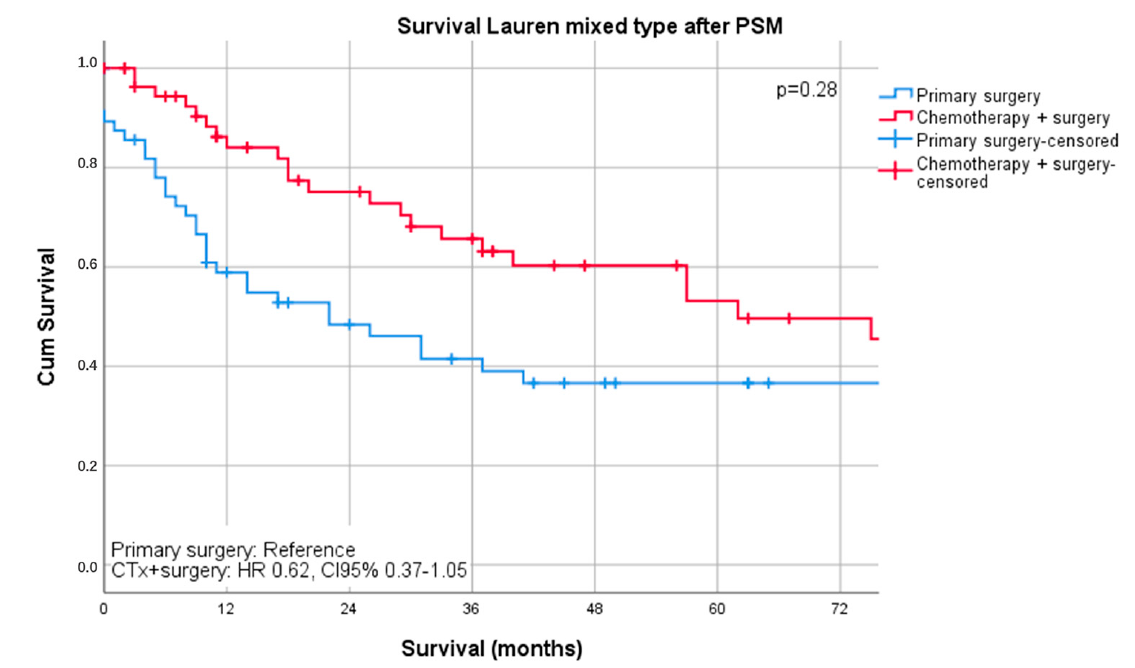
Figure 2. Survival curves for Lauren mixed subtype after PSM stratified by surgery only vs. chemotherapy plus surgery.